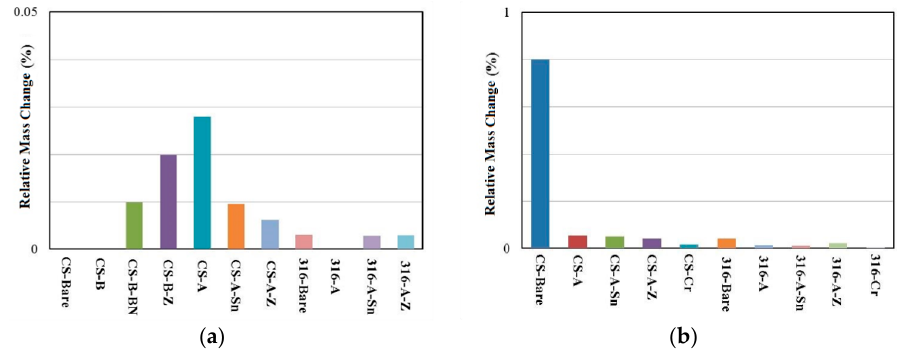
Figure 6. Relative mass change of samples after ( a ) low-temperature, and ( b ) high-temperature corrosive attack after 168 h.